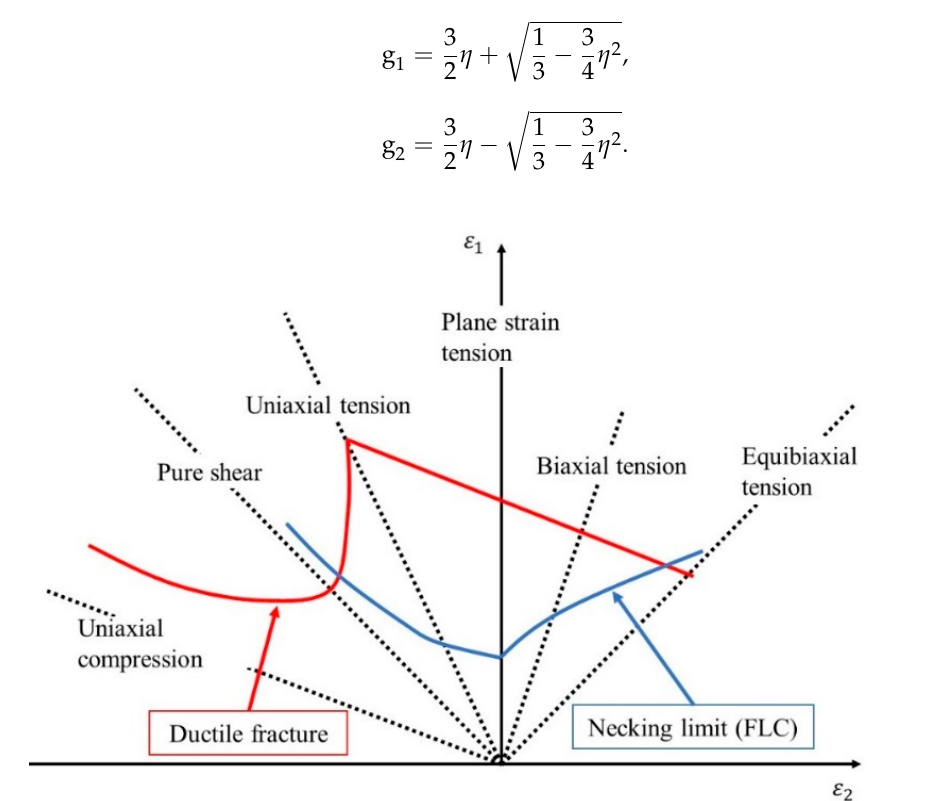
Figure 2. Schematic curves of ductile fracture and necking limit.